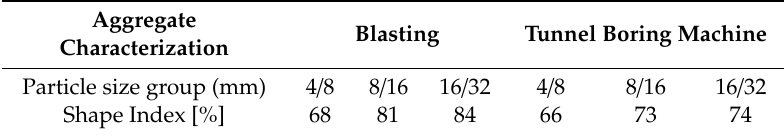
Table 2. Grain shape characterization via shape index (percentage of aggregate weight, at which length to width ratio is ≥ 3) depending on aggregate size and driving method.